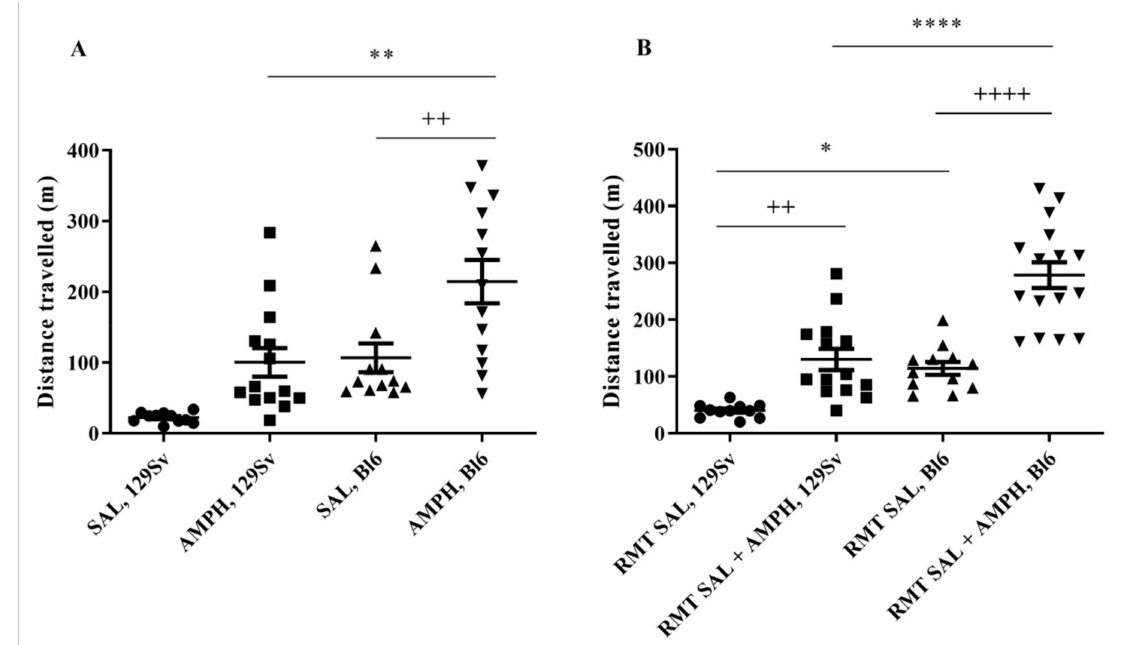
Figure 5. The effect of acute amphetamine (AMPH, 3 mg/kg) treatment in the beginning and at the end of RMT in Bl6 and 129Sv strains. ( A ) AMPH treatment in the beginning of study (HCC) and ( B ) AMPH treatment after repeated saline administrations (RMT). AMPH was administered 30 min before the beginning of motility test and distance travelled was measured for 30 min. Data are presented as mean values ± SD. Bonferroni post hoc analysis after significant two-way ANOVA: * p ≤ 0.05, ** p ≤ 0.01 and **** p ≤ 0.0001 compared to the respective 129Sv mice, ++ p ≤ 0.01 and ++++ p ≤ 0.0001 strain specific comparison. SAL—saline. Number of animals in each group varied from 11 to